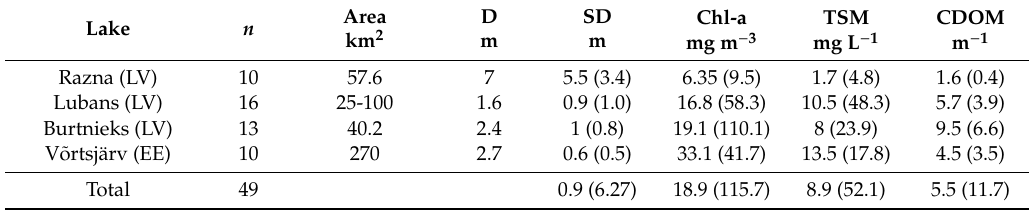
Table 2. The area and average depth (D), median and range in parenthesis of Secchi depth (SD), Chlorophyll-a (Chl-a), total suspended matter (TSM), and colored dissolved organic matter (CDOM) at 400 nm from four different lakes collected during April to November 2018. The n denotes the number of samples. Three out of four of the studied lakes are situated in Latvia (LV) and one in Estonia (EE).